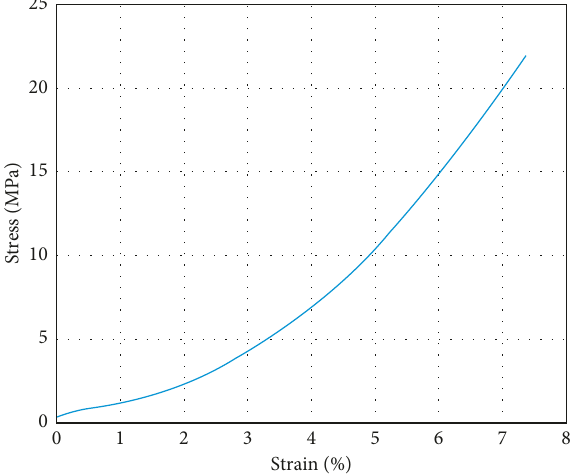
Figure 7: Graph of rubber tensile stress-strain curve.